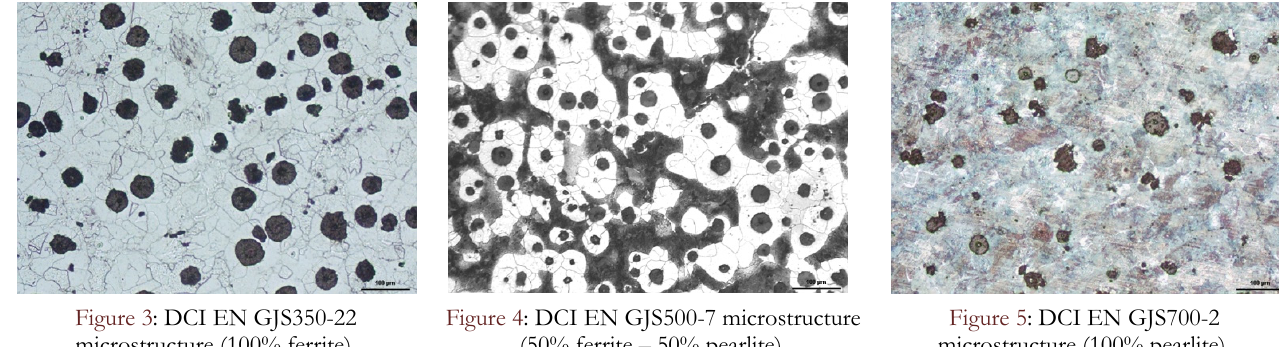
Figure 4: DCI EN GJS500-7 microstructure (50% ferrite – 50% pearlite).